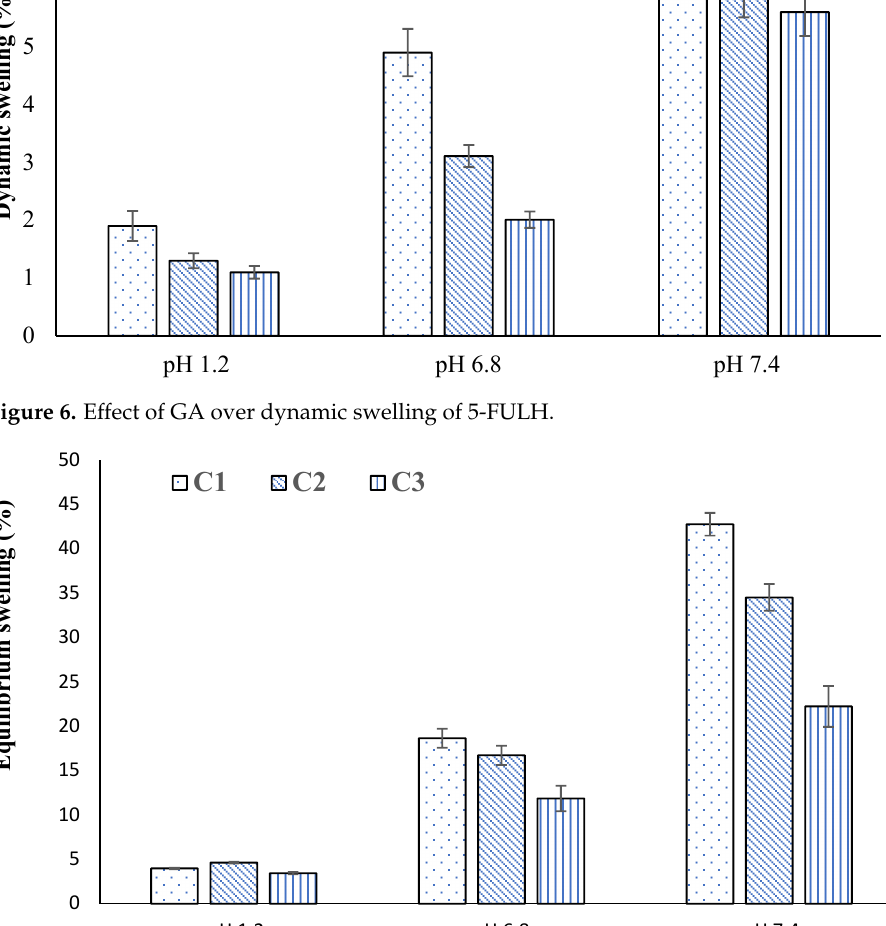
Figure 7. Effect of GA over the equilibrium swelling of 5-FULH.